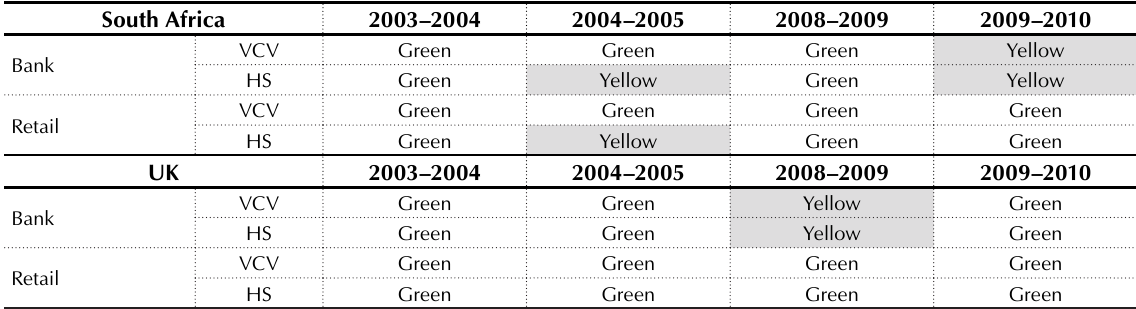
Source: Authors’ calculations.